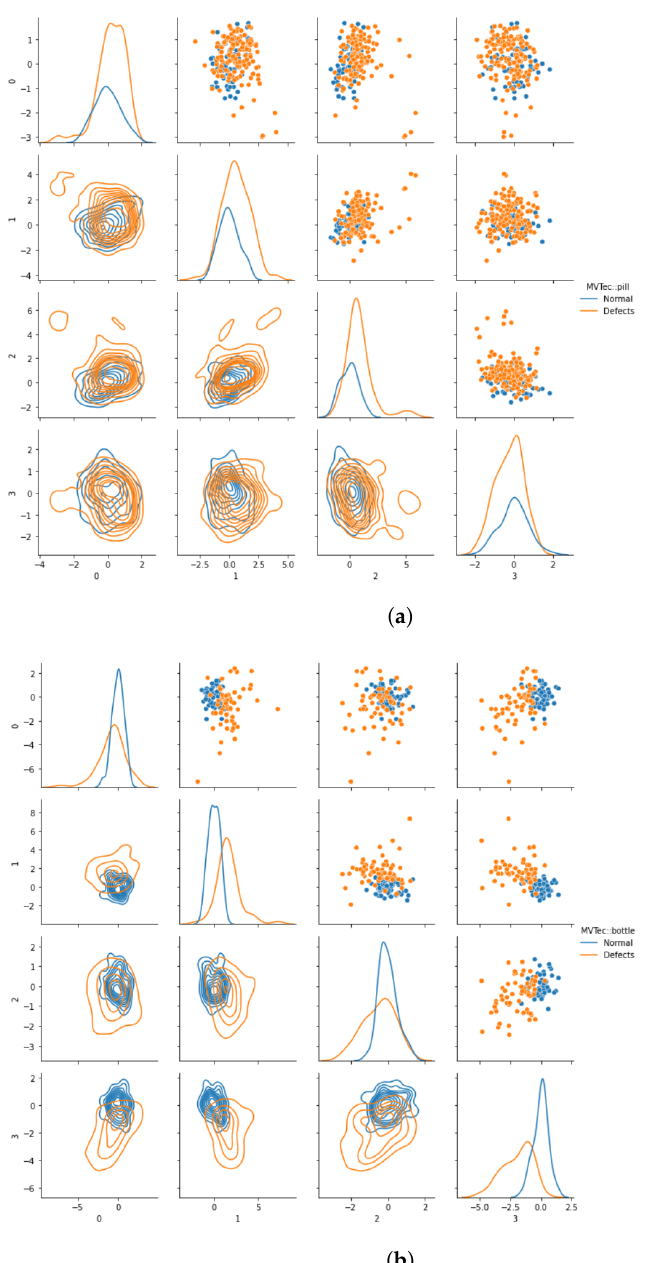
Figure 3. Visualizing the mean-shift between normal and defective examples of the MVTec dataset for ( a ) the pill and ( b ) the bottle classes. For visualization, four random features of the EfficientNet-B4 features where chosen. As hyperparameters, we selected θ = { L = 5, R = 48, τ = 16, A = 96 }